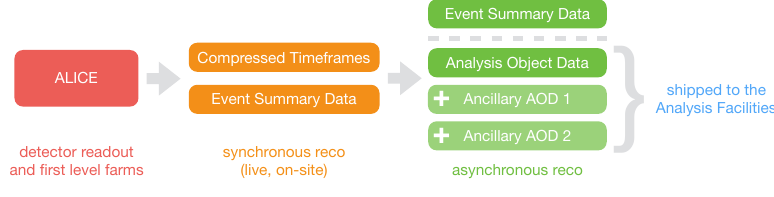
Figure 1. Data flow from the ALICE detector to AODs in O 2